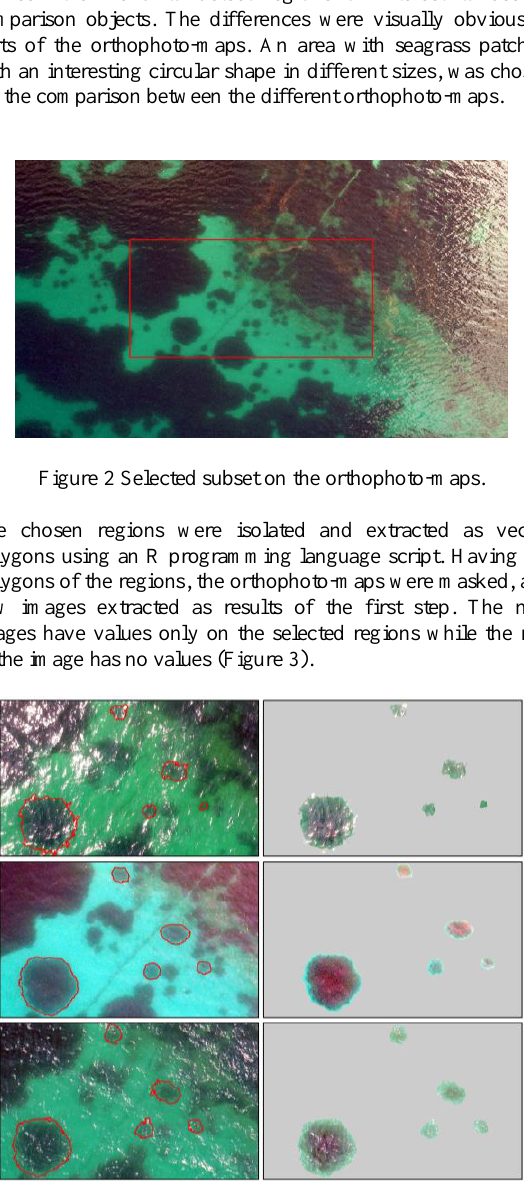
Figure 3 The polygons of the regions of interest (left) and the masked images (right)